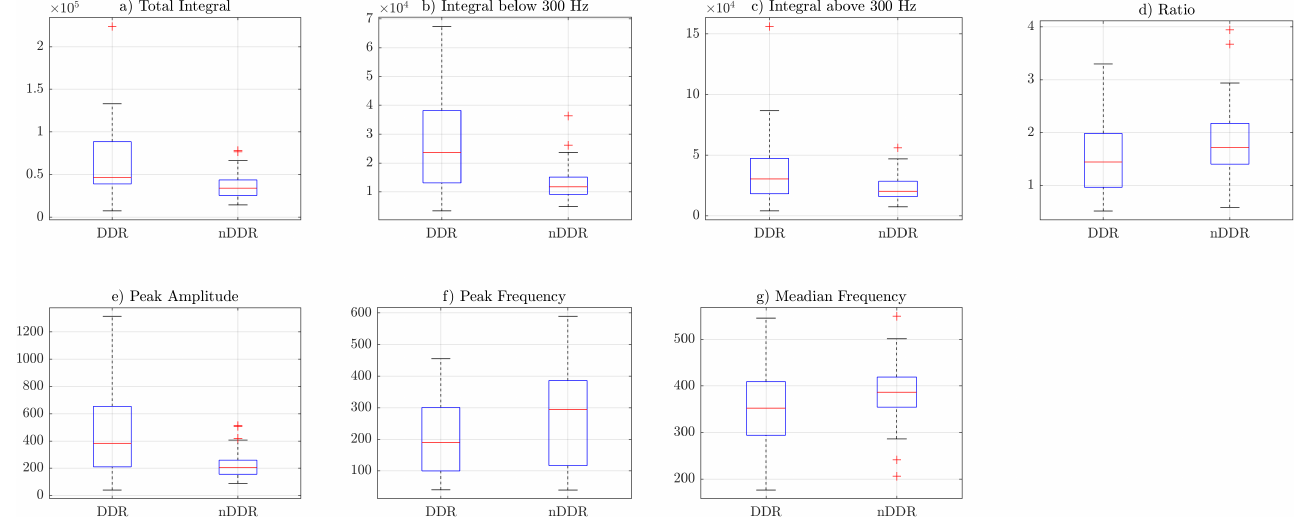
Figure A4. Box plots of norm1 features obtained for the second measurement: ( a ) TI feature, ( b ) IB3 feature, ( c ) IA3 feature, ( d ) IBAR feature, ( e ) PA feature, ( f ) PF feature, ( g ) MF